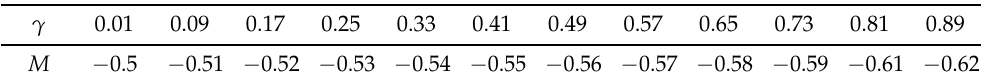
Table 3. Values of the medial correlation of the GCC copula for θ = ( − 1/ γ , − γ , − 1 ) and several values of γ , belonging to Configuration